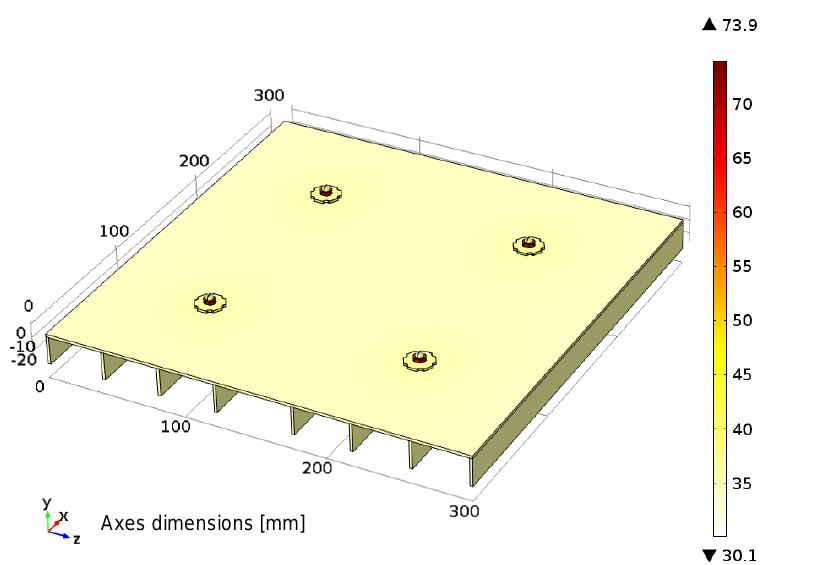
Figure 19. HP-LED luminaire surface temperature for the result optimized by genetic algorithm.